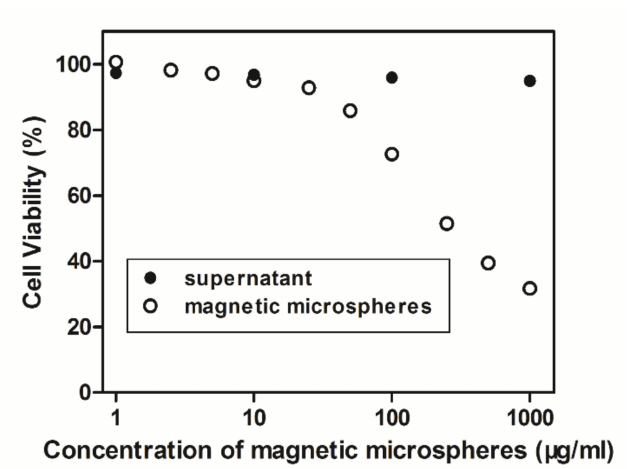
Figure 5. Relation curve of cell viability with the concentration of magnetic